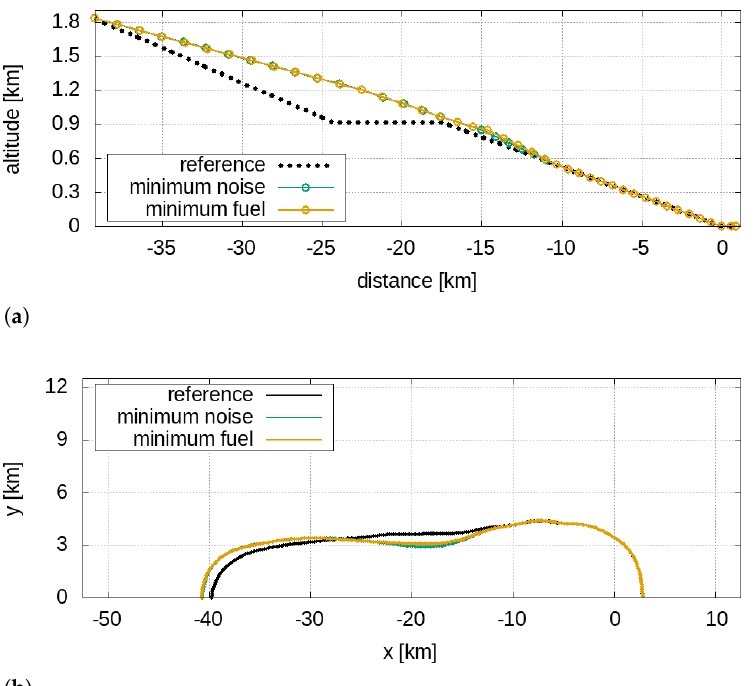
Figure 8. Approachmanoeuvreforthesingle-aisleaircraft: flightpathsand60dBAcontoursforthereference trajectory and the optimal solutions related to the minimum noise and the minimum fuel consumption: